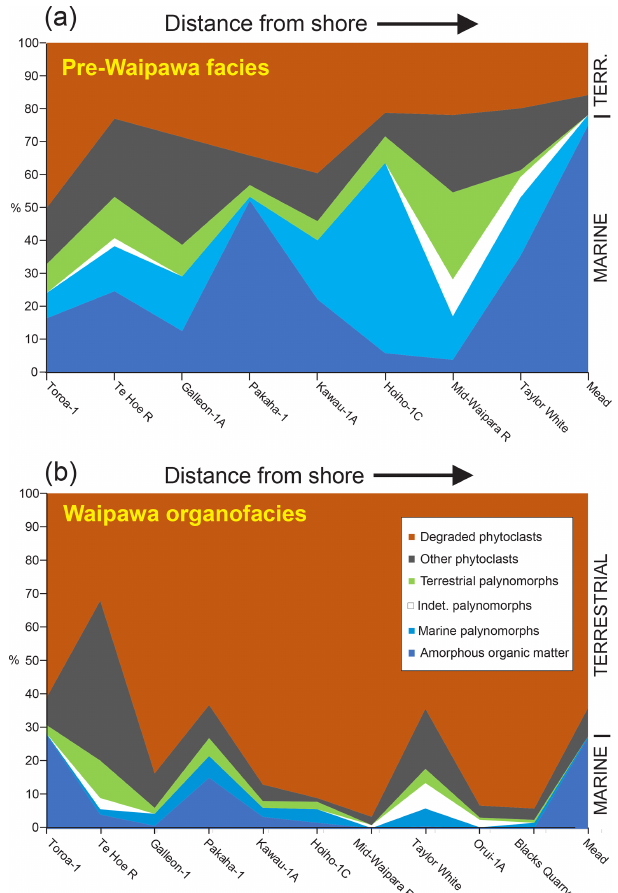
Figure 15. Palynofacies variation in relation to inferred relative dis- tance from shore for (a) Waipawa organofacies and (b) the under- lying Whangai or correlative facies, based on mean values. See Ta- ble S1 for paleo-depth assessments for each locality.